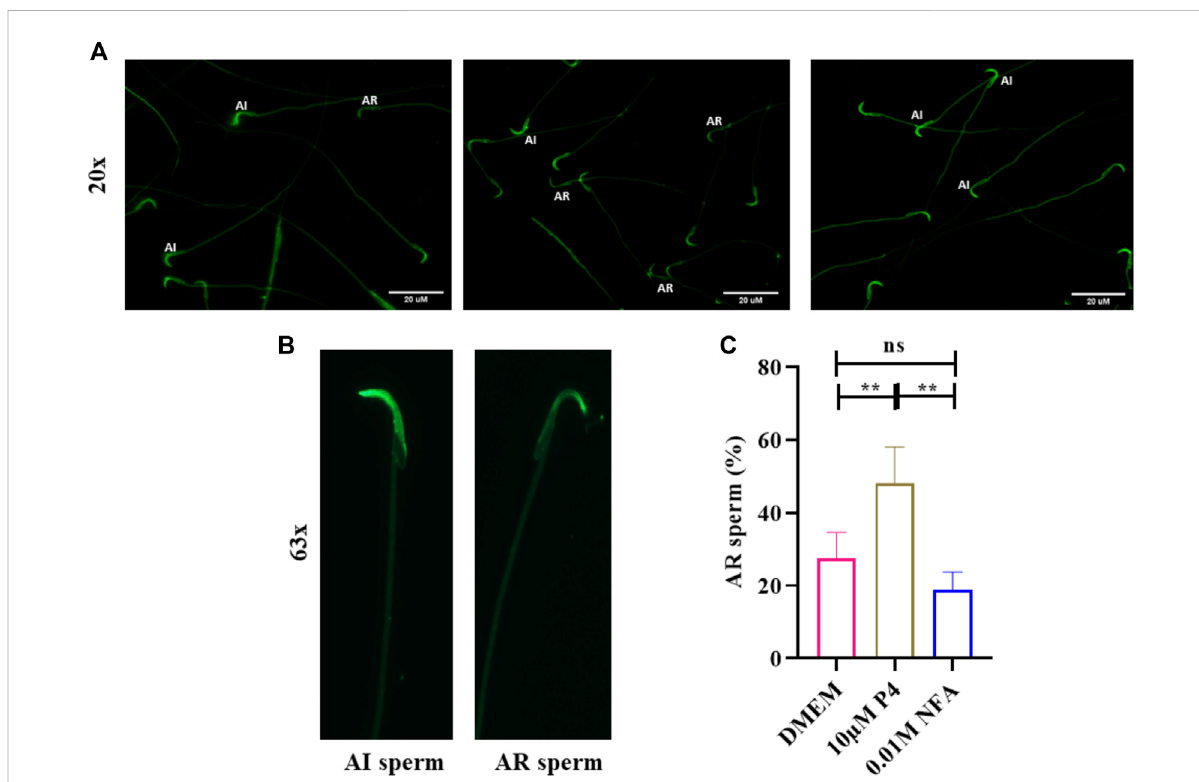
FIGURE 6 NFA does not induce acrosome reactions in sperm. The acrosome reaction was evaluated by PSA-FITC staining. Sperm were incubated in DMEM, without or with 10 μ M progesterone (P4), or 0.01 M NFA for 1 h after capacitation and subjected to PSA-FITC staining. After PSA-FITC staining, sperm were examined by epi fl uorescence microscopy. AR, acrosome reacted sperm; AI, acrosome intact sperm (A,B) . The percentages of acrosome reactedsperm werecalculated bydividing thenumberof acrosome reacted sperm bythetotal number ofsperm for each group (C) . Bars represent mean ±